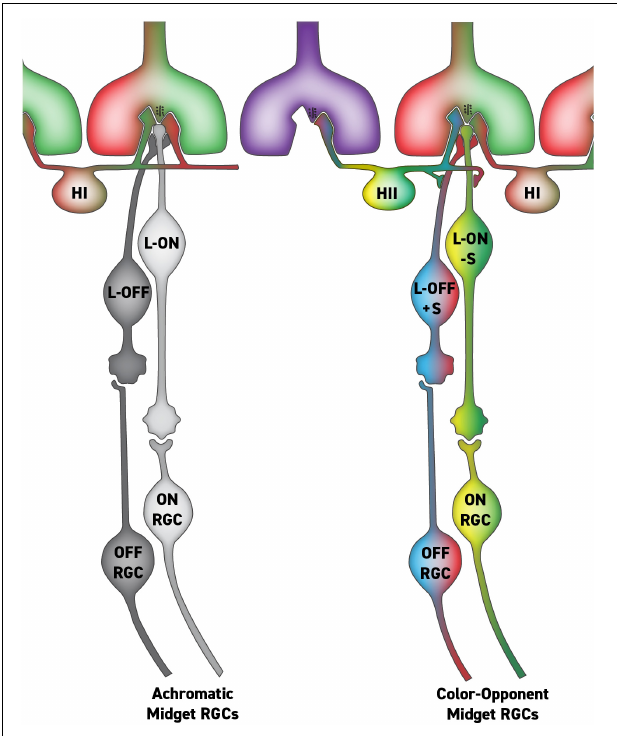
FIGURE 1 | Putative circuit for parallel midget retinal ganglion cell (RGC) pathways with and without S-cone input via HII feed-forward signaling. In this circuit, the single-opponent midget RGCs (left) serve achromatic percepts, while the double-opponent RGCs (right) serve hue